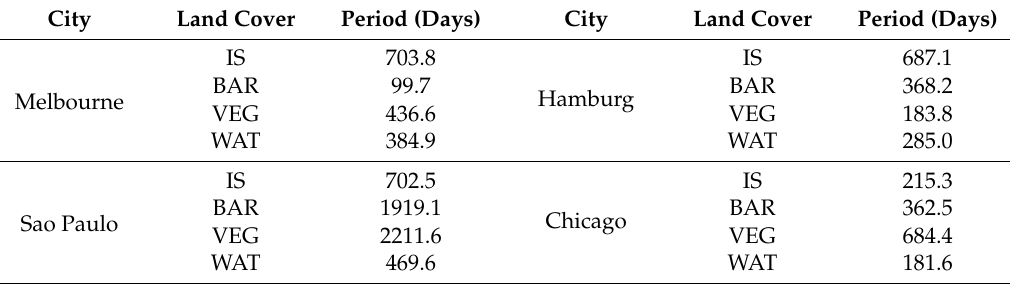
Table 2. The dominant period of each fitted urban land cover variation